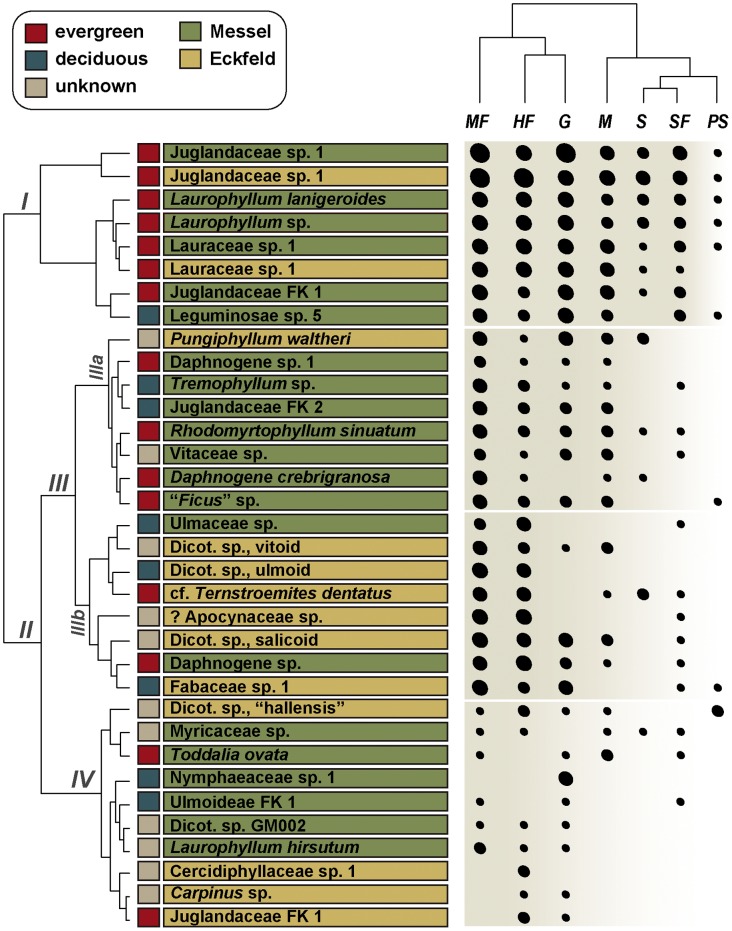
Two-way cluster analysis of insect damage on species–locality pairs, based on relative abundances of the seven functional feeding groups.Each plant from Messel and Eckfeld with at least 50 specimens was included in the analysis. Black circles are scaled according to the relative abundance of each functional feeding group on each plant host. The two-way cluster analysis was performed using the protocol of [11]. The significance of the clusters in Roman numerals is explained in the text. Abbreviations are: MF, margin feeding; HF, hole feeding; G, galling; M, leaf mining; S, skeletonization; SF, surface feeding; and PS, piercing and sucking.